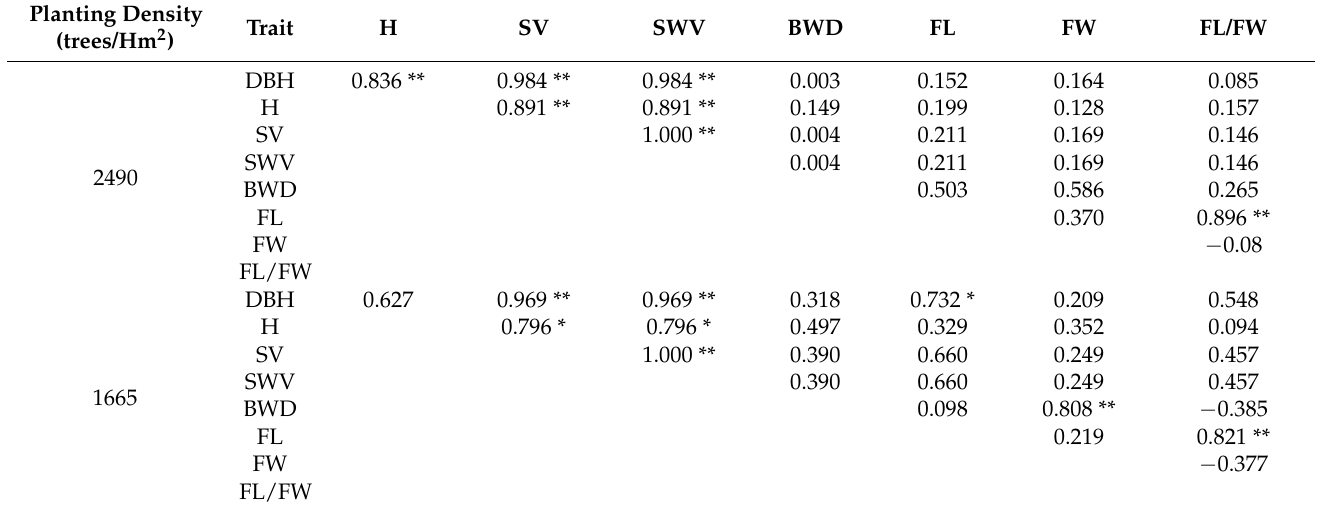
Table 5. Estimated phenotypic correlations between growth traits, wood basic density, and fiber properties of the three triploid hybrid clones at seven planting